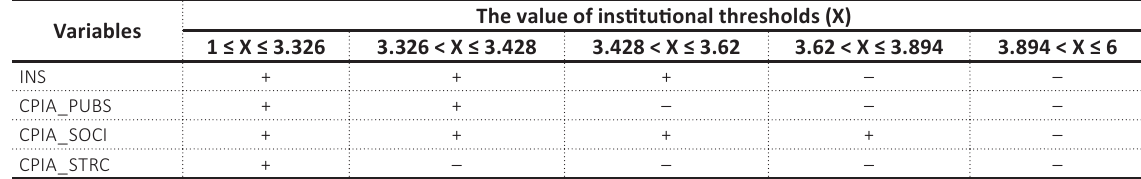
Source: Authors’ elaboration.